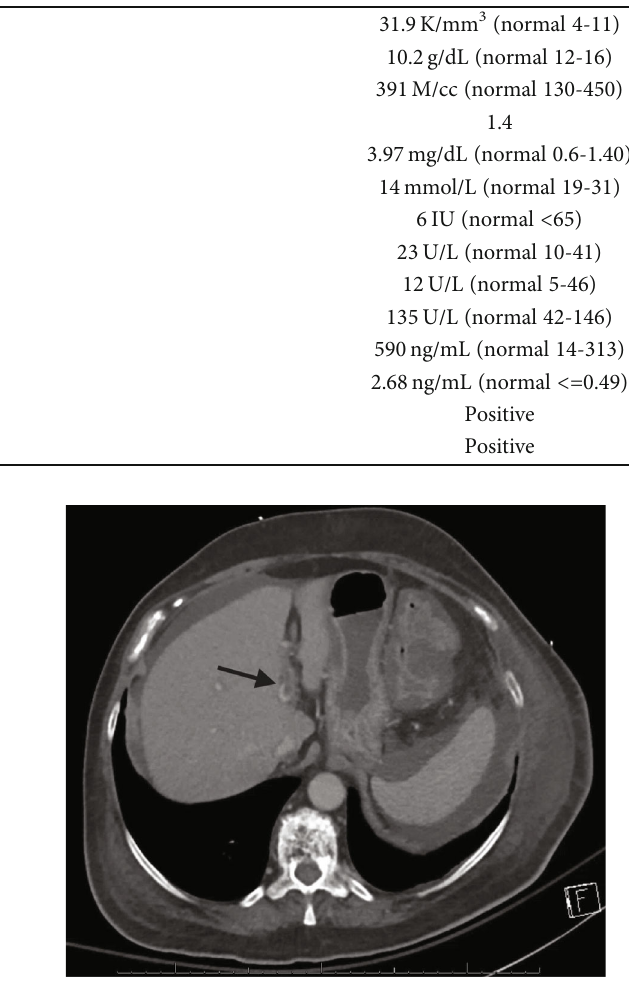
Figure 2: CT abdomen axial view: arrow indicating centrally located fi lling defect in the left portal vein suggestive of acute thrombus.